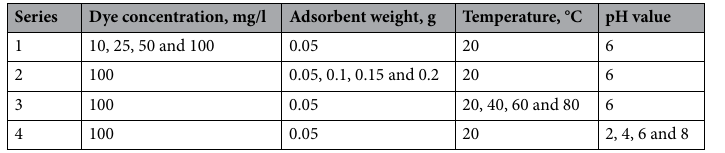
Table 1. Conditions of experimental